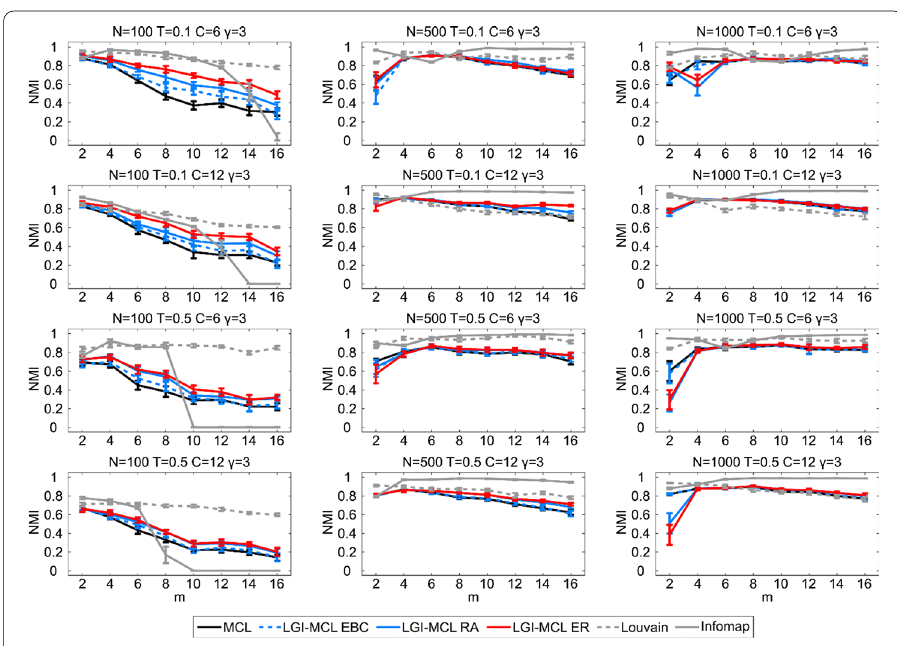
Fig. 2 Community detection on nPSO networks (2nd setting: γ fixed; N , m , T and C changing). Synthetic networks have been generated using the nPSO model with parameters N γ 3 (power-law degree distribution exponent), m = 0.5] (temperature, inversely related to the clustering coefficient) and C For each combination of parameters, 10 networks have been generated. For each network the community detection methods have been executed and the communities detected have been compared to the annotated ones computing the Normalized Mutual Information (NMI). The plots report for each parameter combination the mean NMI and standard error over the random repetitions and show that the MCL performance increases and stabilizes with larger network size at γ